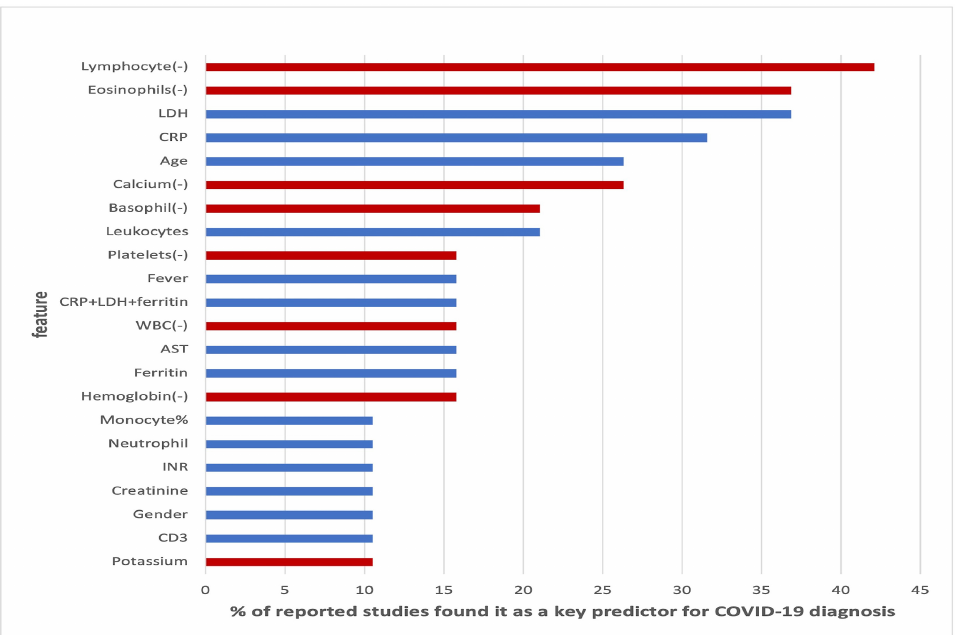
Figure 7. Top features found as most important features in diagnosis of COVID-19 modified from [23].